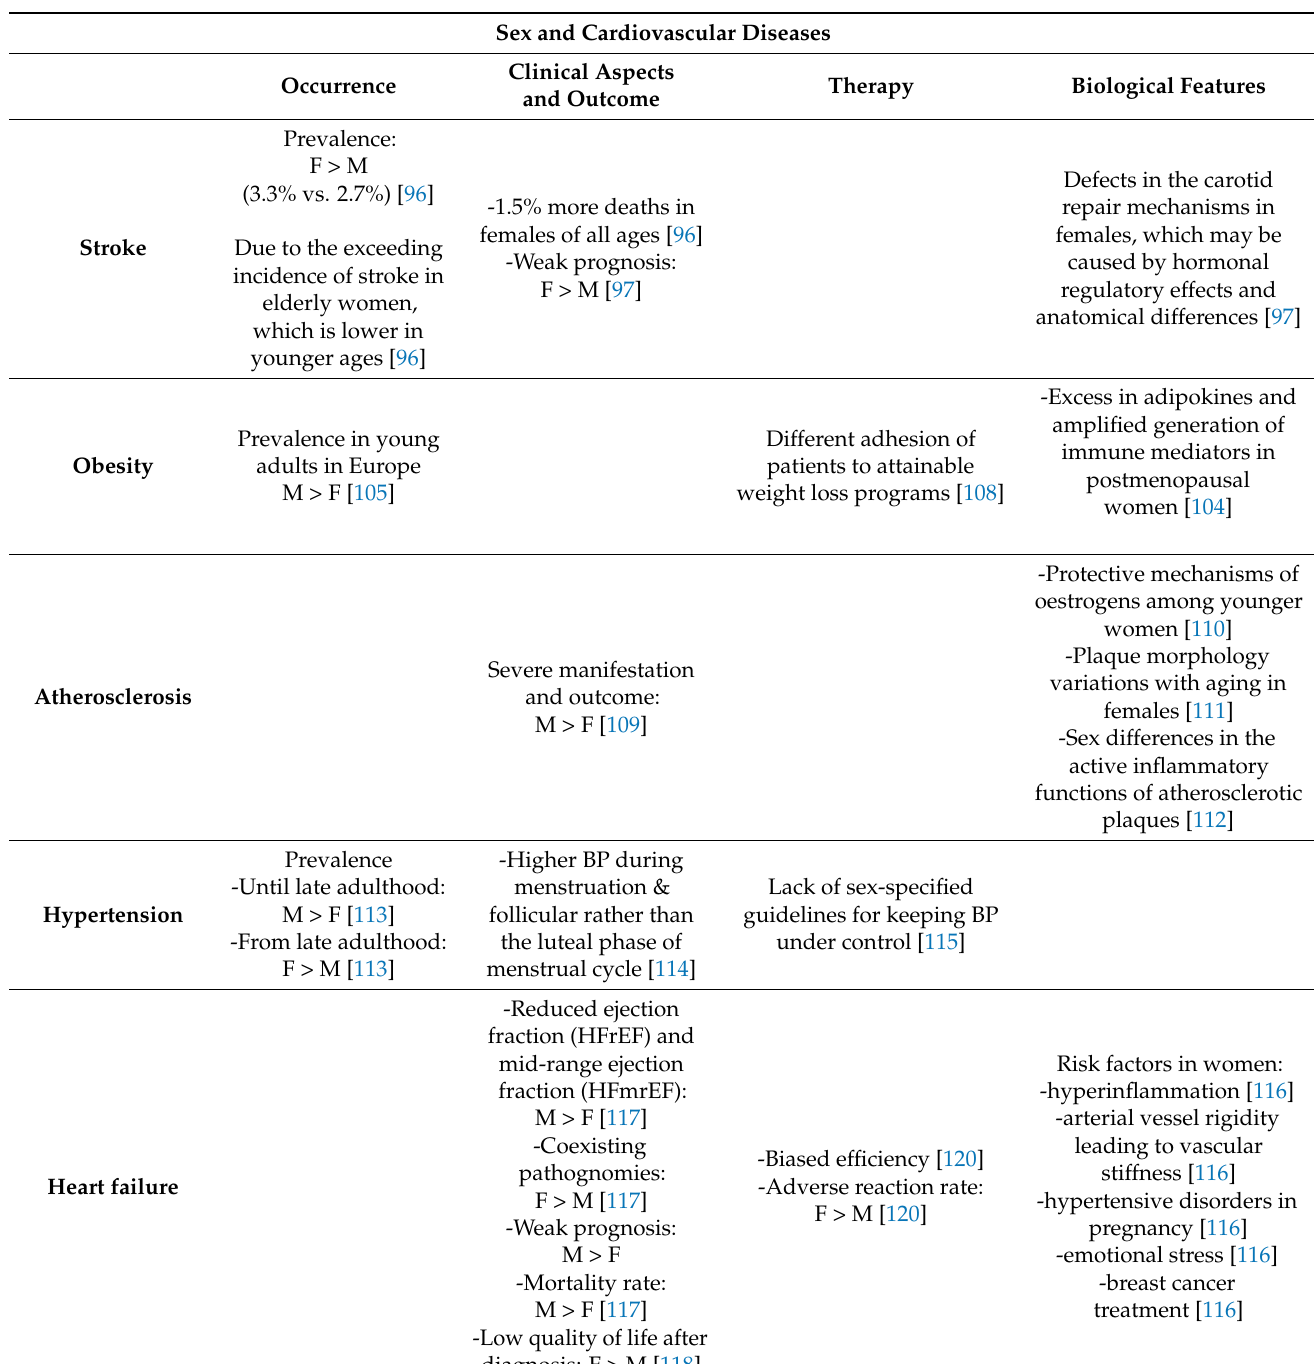
Table 3. Sex differences in cardiovascular diseases. Some risk factors for CVD are described here together with some features of myocardial infarction. In particular, occurrence, clinical aspects and some notes on sex differences as concerns therapy and biological features are